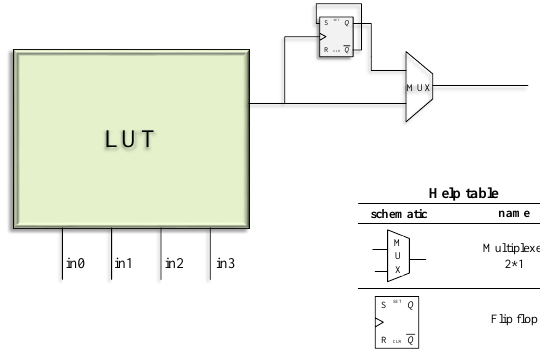
Figure 3. The structure of an